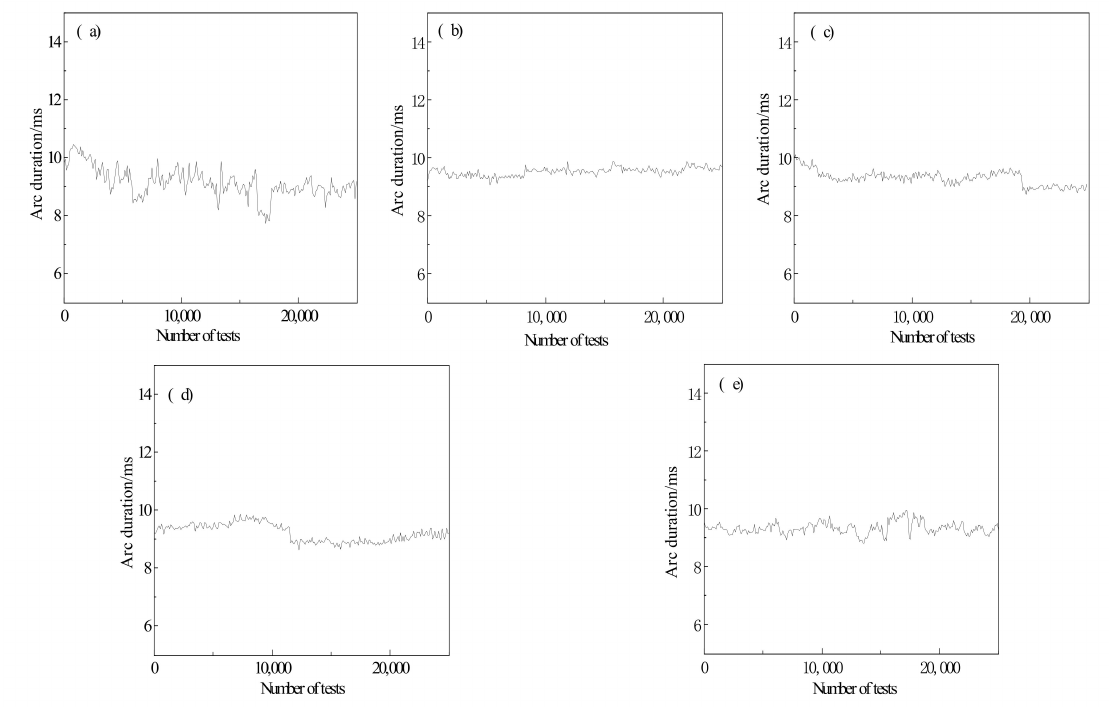
Figure 5. Arc duration of Sn 1 − x Cr x O 2 contact material. ( a ) x = 0; ( b ) x = 0.083; ( c ) x = 0.125; ( d ) x = 0.167; ( e ) x = 0.25.